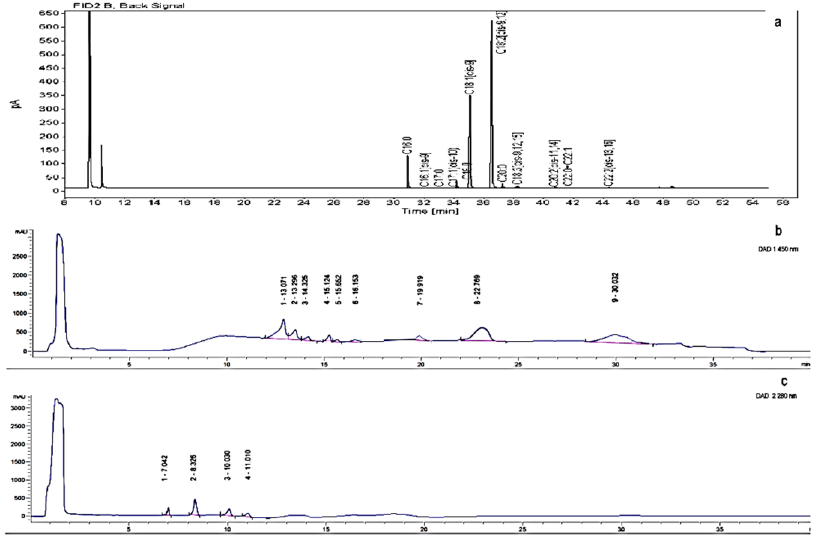
Figure 1. The representative chromatograms of ( a ) fatty acids, ( b ) carotenoids (numbers respond to compounds in Table 2), and ( c ) tocopherols (numbers respond to compounds in Table 3). Table 2. Parameters of method validation for carotenoids 1 .